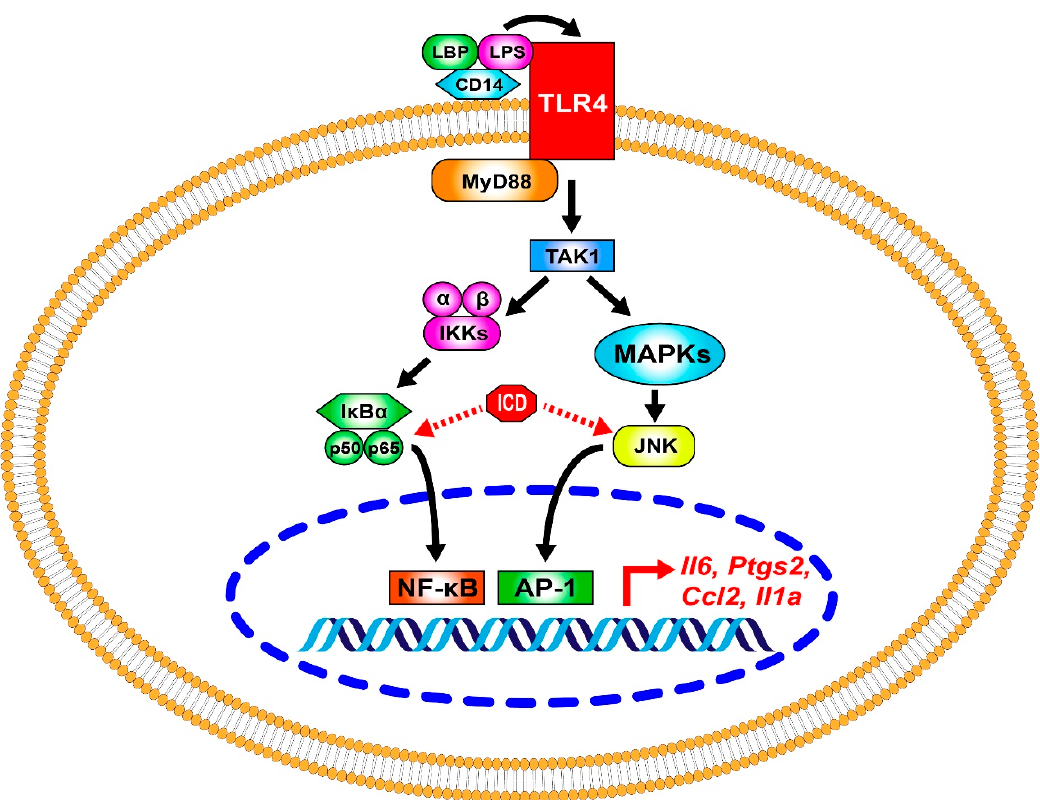
Figure 6. Schematic diagram of ICD effects in macrophages.